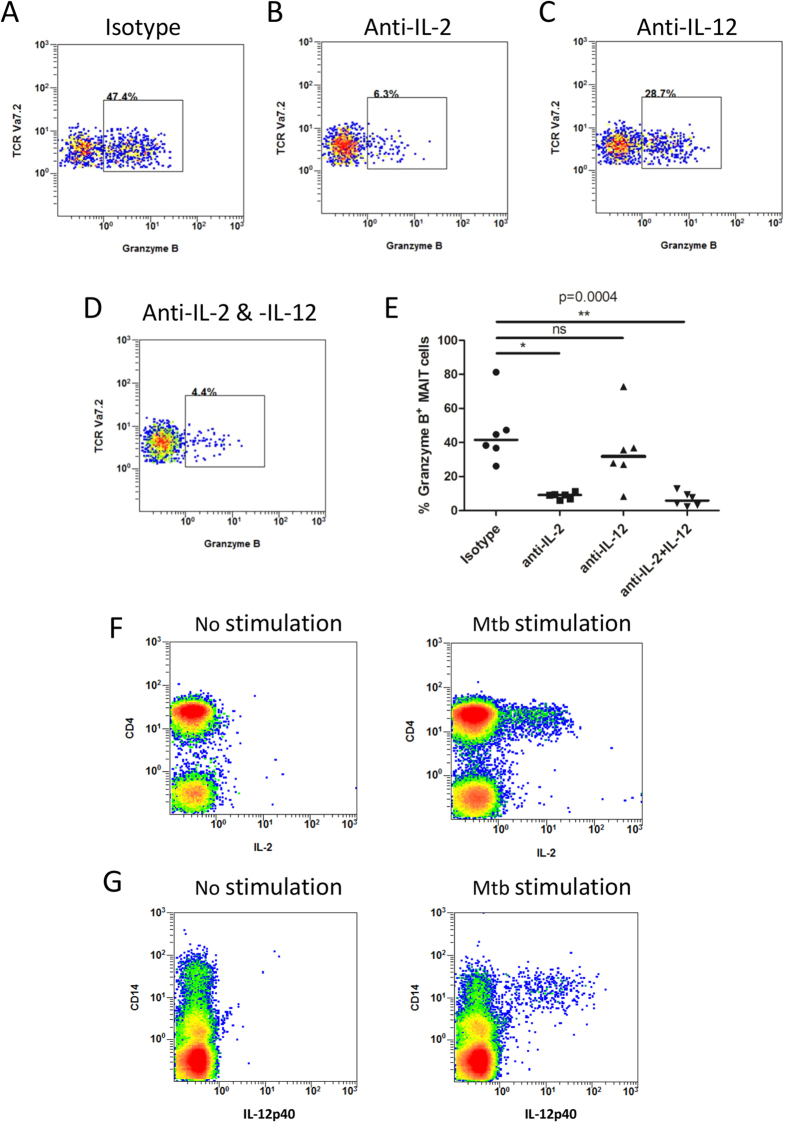
The role of cytokines on granzyme B production in MAIT cells from tuberculous pleural effusions.(A–D) Representative flow plots showing granzyme B production in Mtb-stimulated MAIT cells in the presence of isotype antibody control (A), or blocking antibody to IL-2 (B) and IL-12 (C), or combined blocking antibodies to both IL-2 and IL-12 (D). (E) Blockade of IL-2, but not IL-12, led to significantly reduced expression of granzyme B (n = 6). (F) Representative flow plots showing IL-2-producing cells in the tuberculous pleural effusions. Cells from tuberculous pleural effusions (n = 6) were not stimulated (left) or stimulated with Mtb lysates (right). All cells were gated and CD3+CD4+ T cells were identified as CD4+ T cells. (G) Representative flow plots showing IL-12p40-producing cells. Cells from tuberculous pleural effusions (n = 6) were not stimulated (left) or stimulated with Mtb lysates (right). All cells were gated and CD14+ cells were identified. The Friedman’s test (p < 0.0001), followed by Dunn’s multiple comparison test was used for statistical analysis among groups in Fig. 6E. Horizontal bars in the scatter plots indicate medians. *p < 0.05; **p < 0.01; ns: no significant difference.